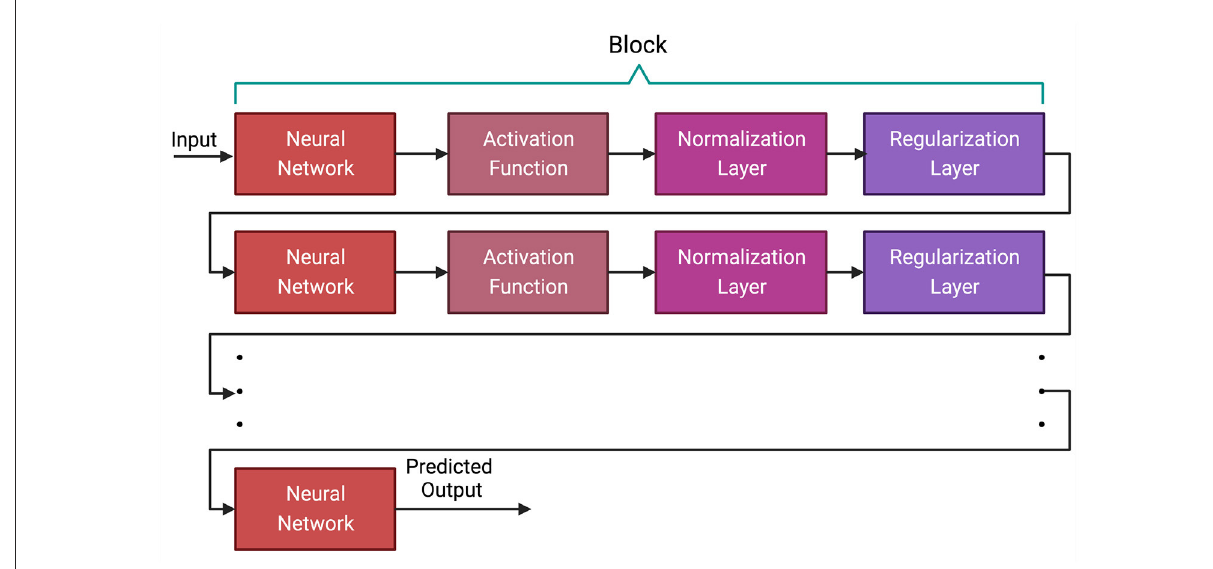
FIGURE1 General architecture of a deep learning algorithm. All the layers between the first and last layer are called hidden layers. The first layer is the input layer and the last layer is the output layer. A neural network layer is typically followed by an activation function and then by normalization and regularization layers. Based on the architecture of the deep learning model, some of these layers, such as normalization and regularization layers, may not be present in a block.